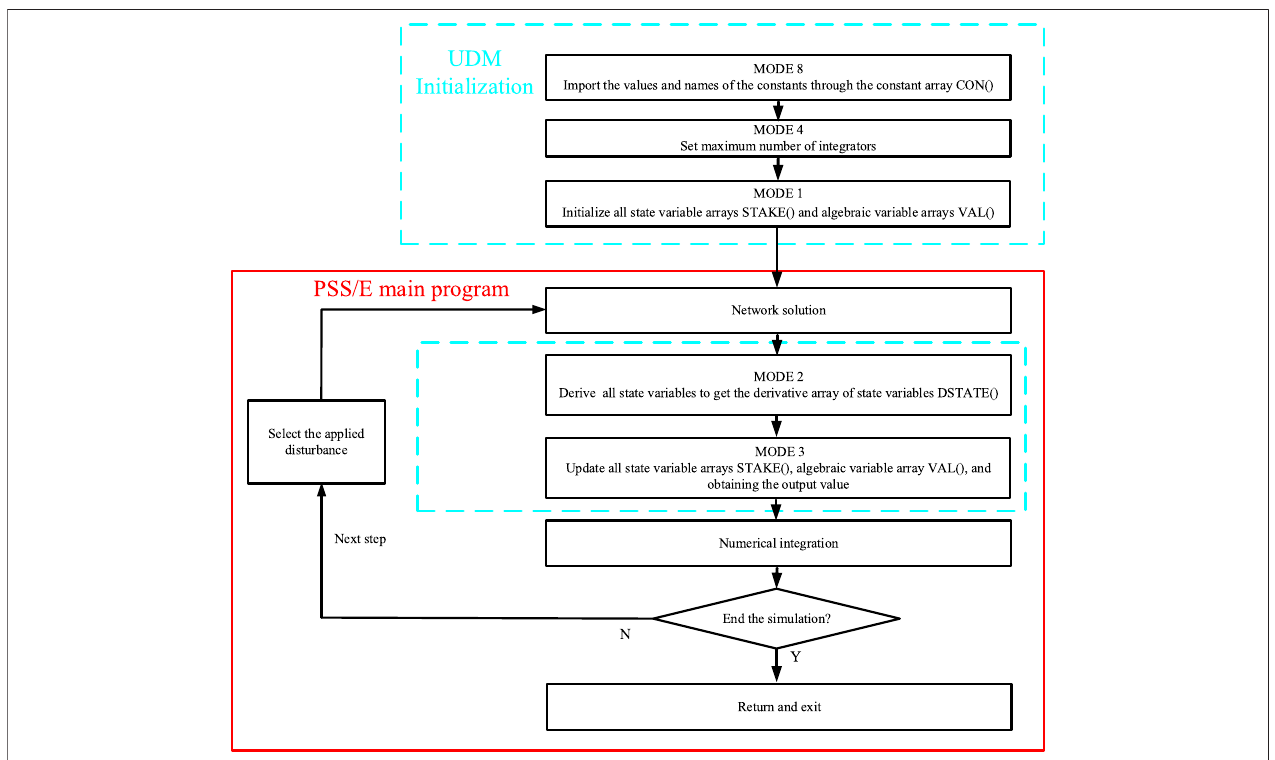
FIGURE 3 | Flow of dynamic simulation based on MODE.